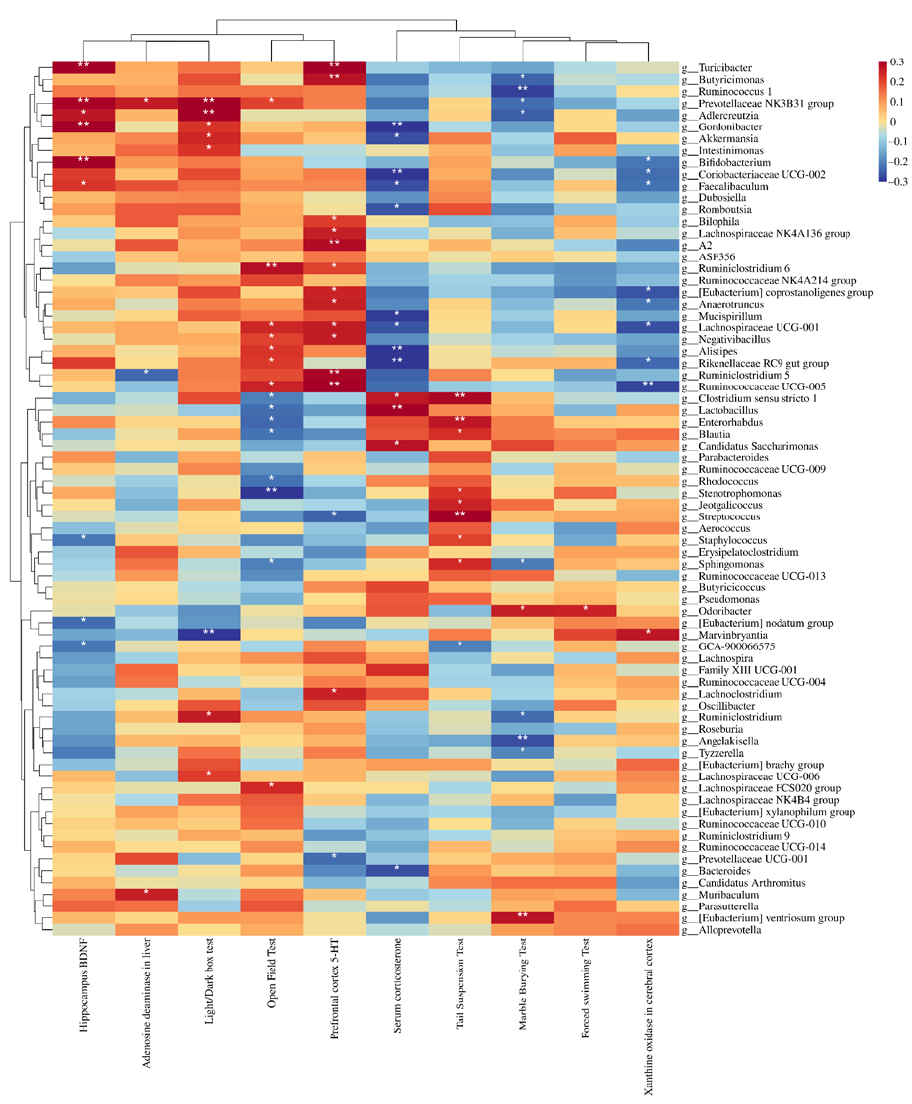
Figure 8. Correlation between bacterial abundance and behavioural indexes, neurobiological indexes, and purine metabolism indexes. * p < 0.05; ** p < 0.01.